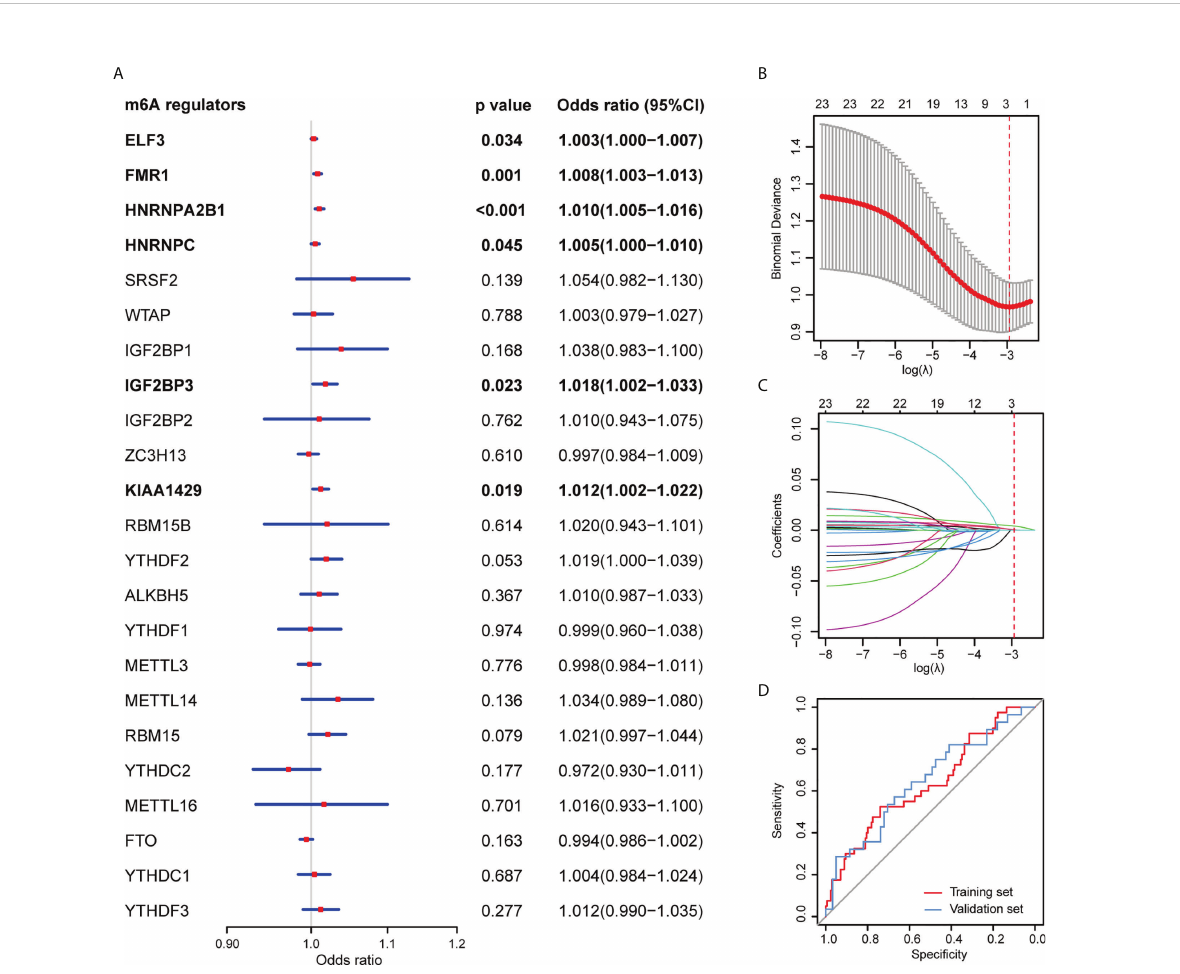
FIGURE 2 Construction and assessment of the m6A-related gene signature. (A) Univariable logistic regression analyses evaluating the predictive ability of m6A methylation regulators for treatment response of urothelial carcinoma patients. (B) Tuning parameter ( l ) selection in the LASSO model used 10-fold cross-validation via minimum criteria. Binomial deviances from the LASSO regression cross-validation procedure were plotted as a function of log( l ). The numbers along the upper x-axis represent the average number of predictors. The red dots indicate the average deviance values for each model with a given l , and the vertical bars through the red dots show the upper and lower values of the deviances. The dotted vertical lines are drawn at the optimal values where the model provides its best fi t to the data. The optimal l value of 0.053 with log ( l ) = -2.936 was chosen. (C) LASSO coef fi cient pro fi les of the 23 m6A methylation regulators. The dotted vertical line is drawn at the value selected using 10-fold cross-validation in Figure 2B, where optimal l resulted in 2 nonzero coef fi cients. (D) ROC curves of the gene signature in the training and validation